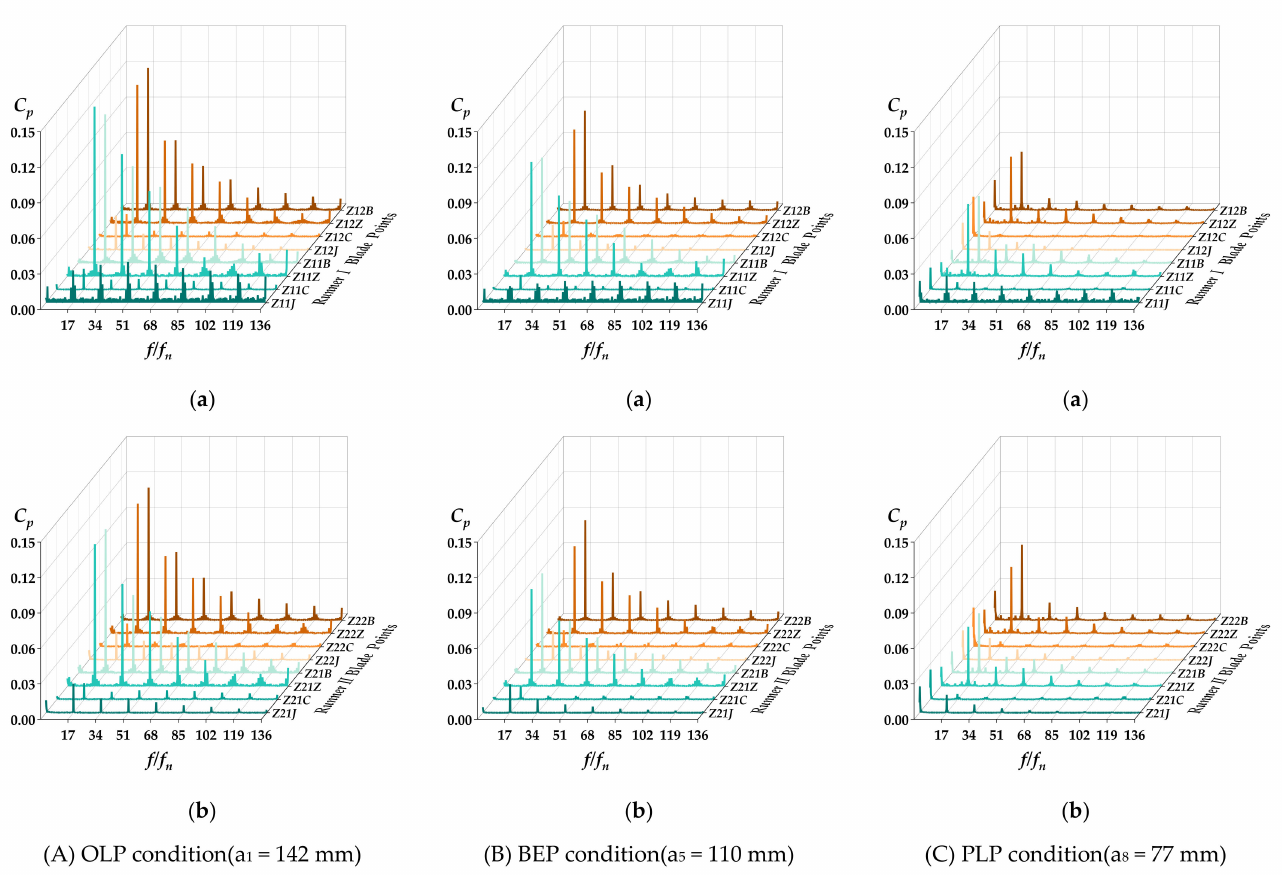
Figure 19. Spectrum of pressure pulsation at runner blade monitoring points under different working conditions. ( a ) Data from blades of the runner I side; ( b ) data from blades of the runner II